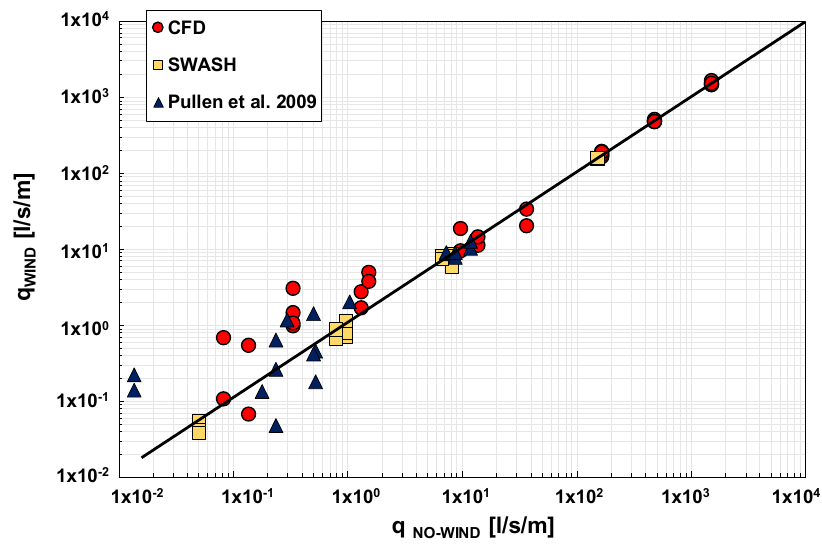
Figure 12. Numerical results vs HRW laboratory experiments of mean overtopping discharges [5] with and without wind.